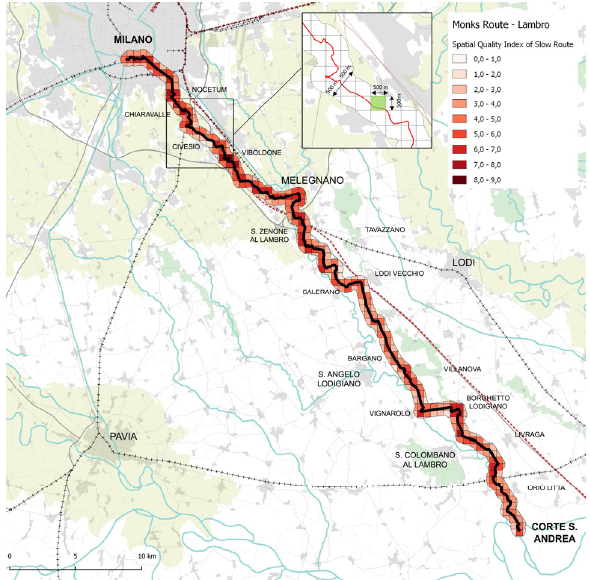
Figure 1. Map of graded grid defined as calculation surface of the route, with evidence of scores (0–10) for each cell. Detail with buffer (500 m) and cell size (500x500